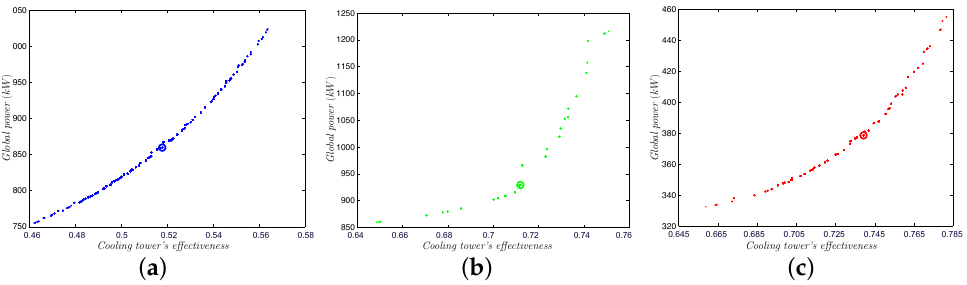
Figure 8. Pareto fronts and selected optimal solutions for 3 of the 35 operating points used in the implementation of the optimization with Micro-GA with stopping criterion after 90 s. ( a ) Operational point 8; ( b ) Operational point 16; ( c ) Operational point